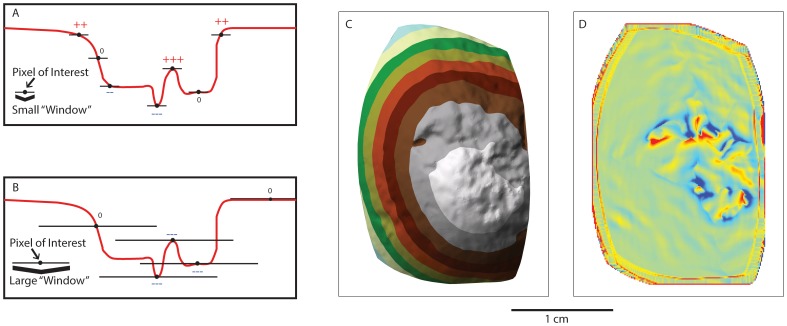
A schematic representation of the topographic position index.This shows a schematic description of the TPI index on two identical surfaces with a small window size (A) and large window size (B). The window size changes the resolution of identifying high values (peaks) versus low values (valleys) of the TPI statistic (redrawn from Jenness 2002). C) This is an experimentally damaged percussive tool showing elevation values represented by a TIN model. D) This is the TPI index of the same specimen. Note the edge effects around the borders of the TPI model.